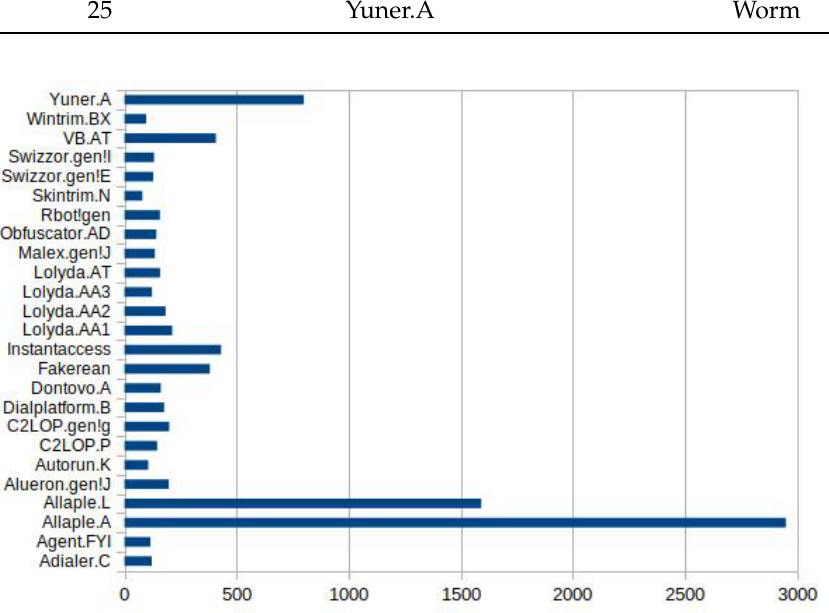
Figure 2. Number of samples per